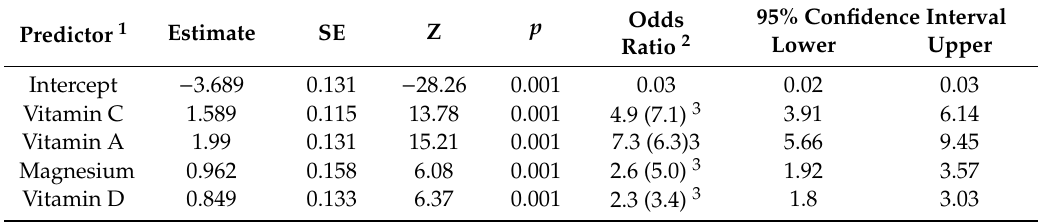
Table 6. Binomial logistic regression model between NAR values and the diverse diet group in ELANS. Predictor